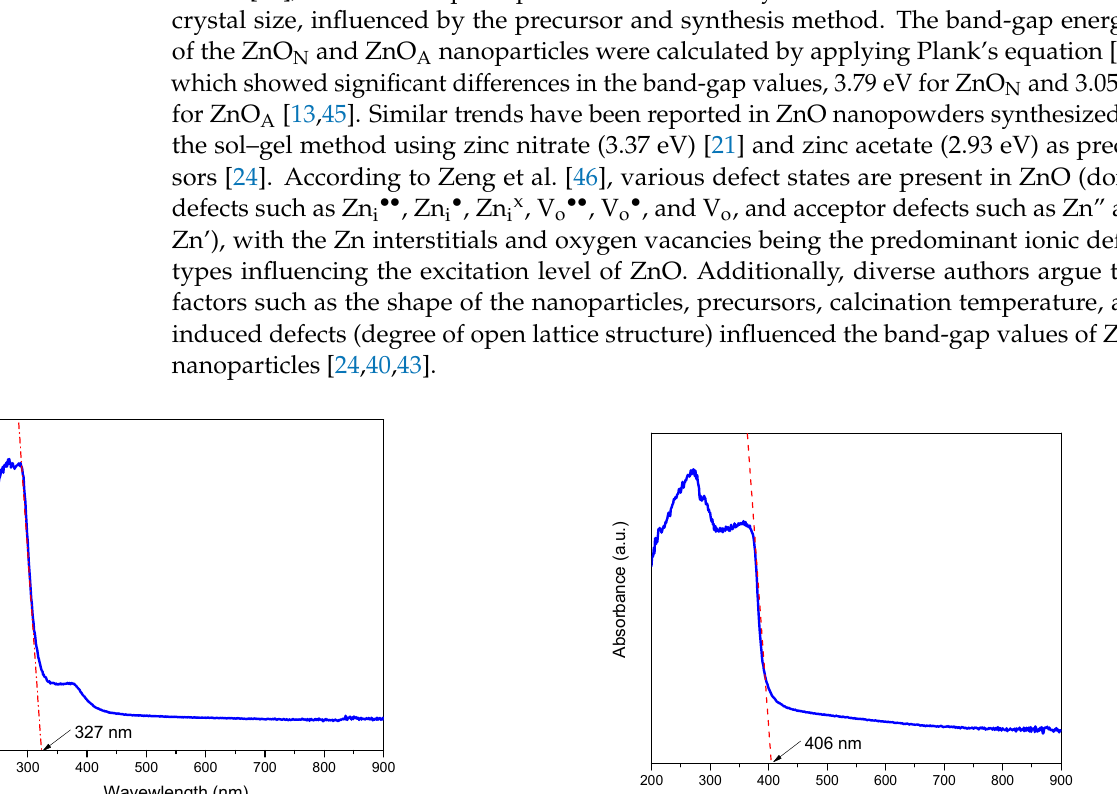
Figure 2. Micrographics of TEM of ZnO N ( a ) and ZnO A ( d ); SAED of ZnO N ( b ) and ZnO A ( e ); and particle size distribution of ZnO N ( c ) and ZnO A ( f ).